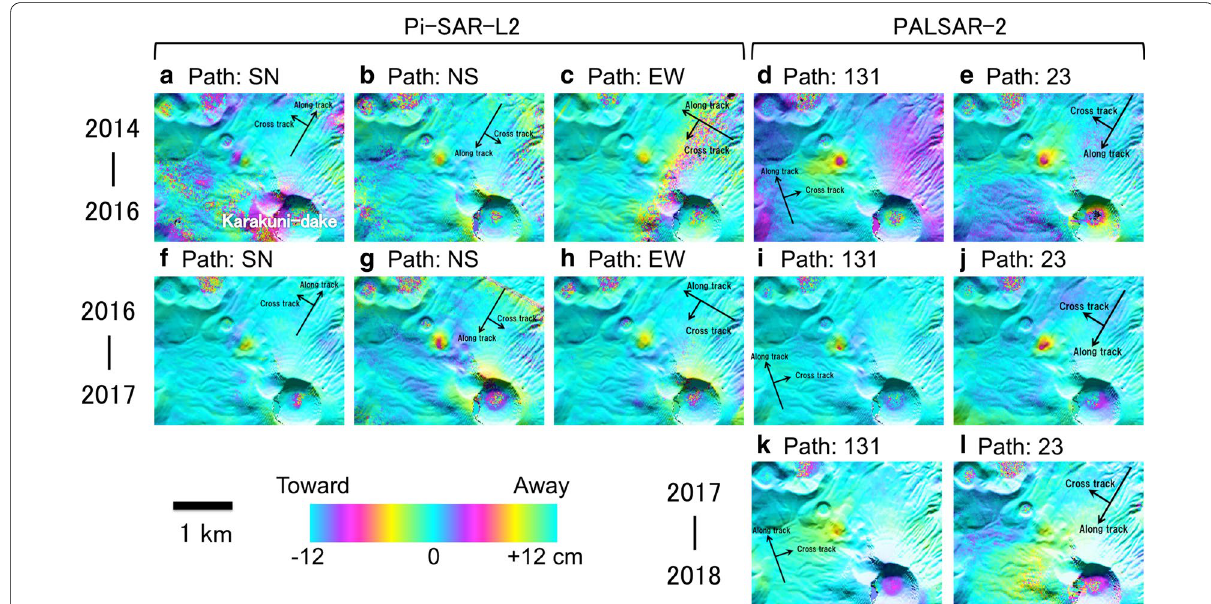
Fig. 4 Interferograms generated from Pi-SAR-L2 ( a , b , c , f , g , and h ) and PALSAR-2 data ( d , e , i , j , k , and l ). a – e and ( f – j ) are the interferograms used to estimate 3D deformation, spanning 2014–2016 and 2016–2017, respectively. k and l were interferograms used to estimate 2.5D